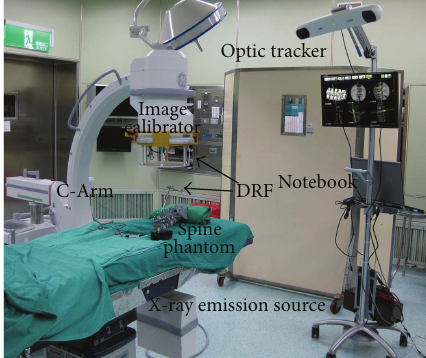
Figure 1: The self-developed C-Arm image-assisted surgical navi- gation system.